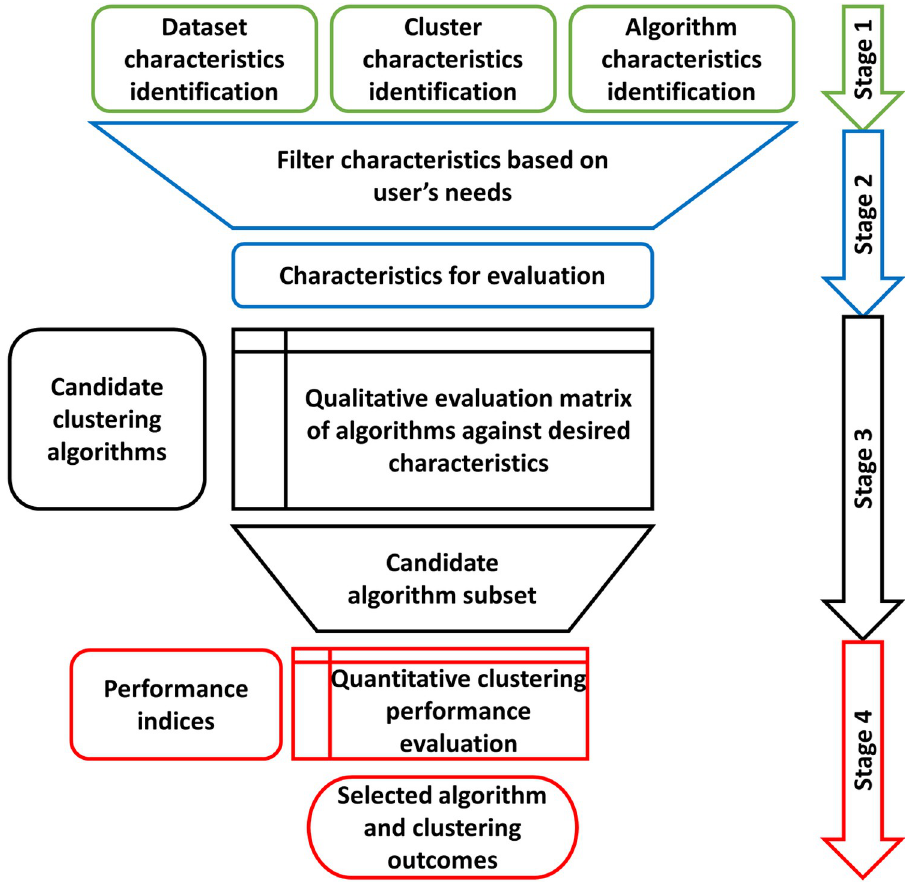
Fig 1. Analysis framework for clustering algorithm